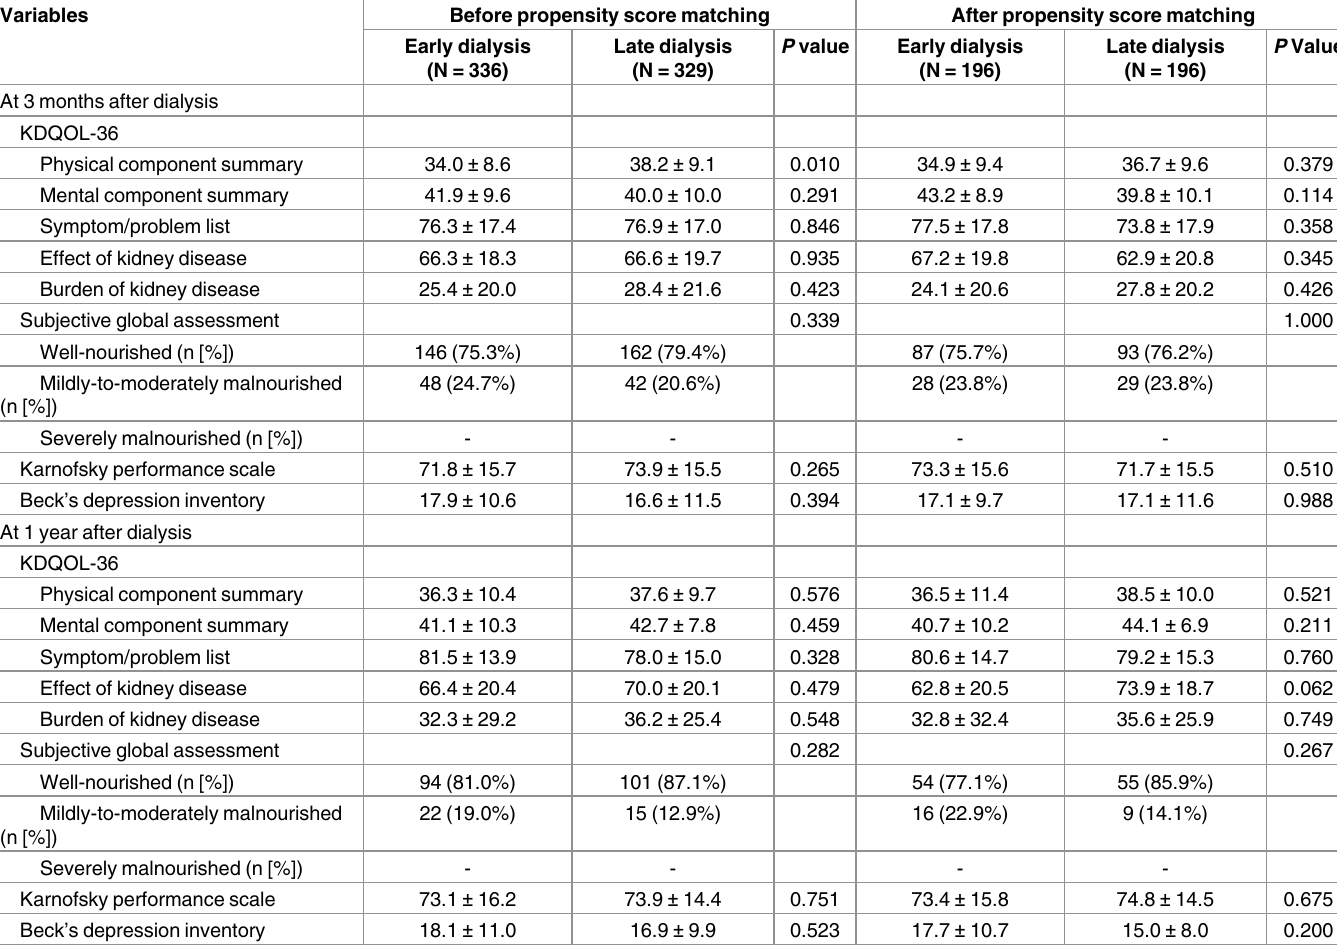
Table 3. Analyses of quality of life, nutritional status, and physical and mental performance using the KDQOL-36 survey,subjective global assess- ments, Karnofsky performance scale values, and Beck’s depression inventory scores before and after propensity score matching at 3 months ver- sus 1 year after dialysis initiation in the 2 groups based on the timing of dialysis initiation stratified by the median eGFR before